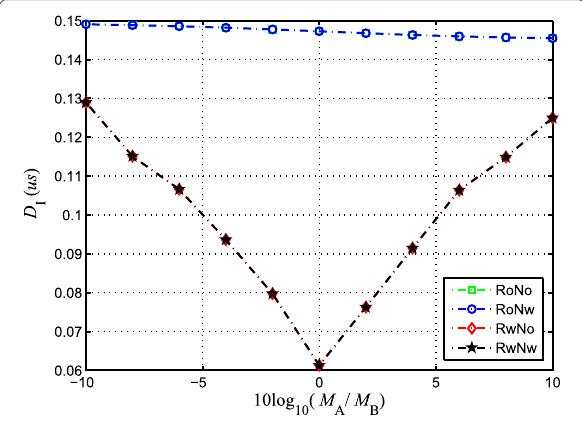
Fig. 10 D I performance comparison of the four schemes in Example 2, where h A = [1 2 2 3 4 5 5 6 6] and h B = [6 6 6 5 4 4 3 2 1 1]